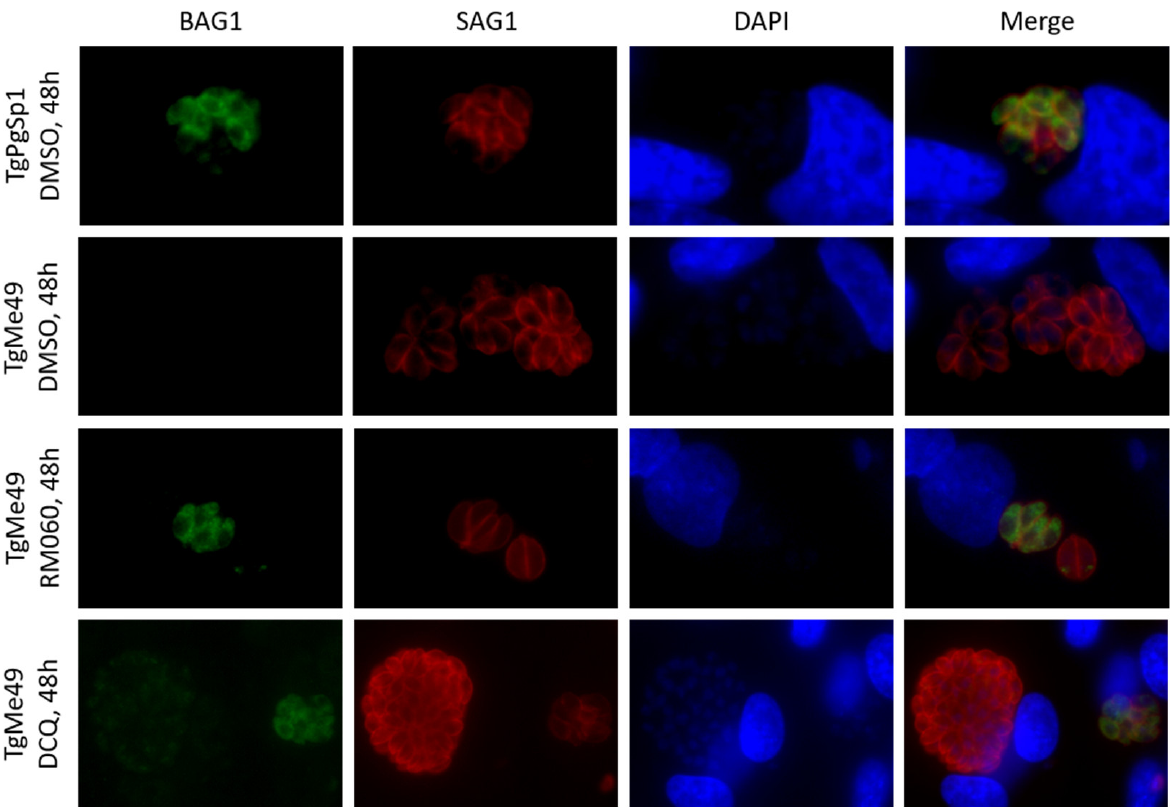
Figure 4. Immunofluorescence staining of HFF monolayers infected with T. gondii Me49 (TgMe49) tachyzoites after treatment with RMB060 and DCQ for 48 h. TgMe49 treated with the corresponding amount of DMSO were used as negative control. As positive control, TgPgSp1 were fixed and processed identically. BAG1 is labelled in green, SAG1 staining is red, and nuclei are stained with DAPI.